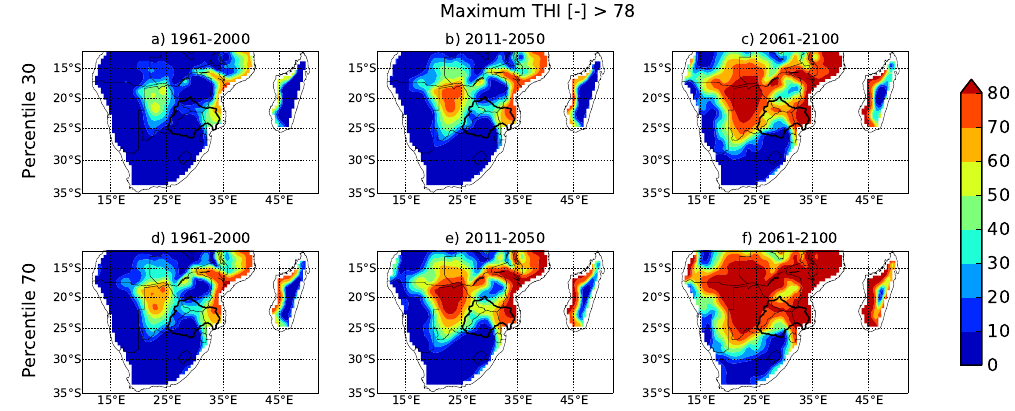
Fig. 2. Same as Fig. 1 but for changes in the climatology of DJF frequency of occurrence of days with THI higher than